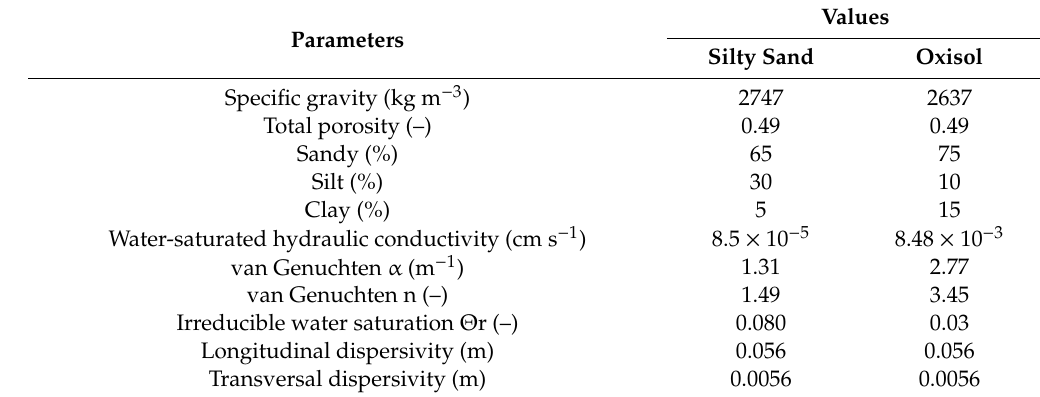
Table 1. Porous media properties. LNAPL: light non-aqueous phase